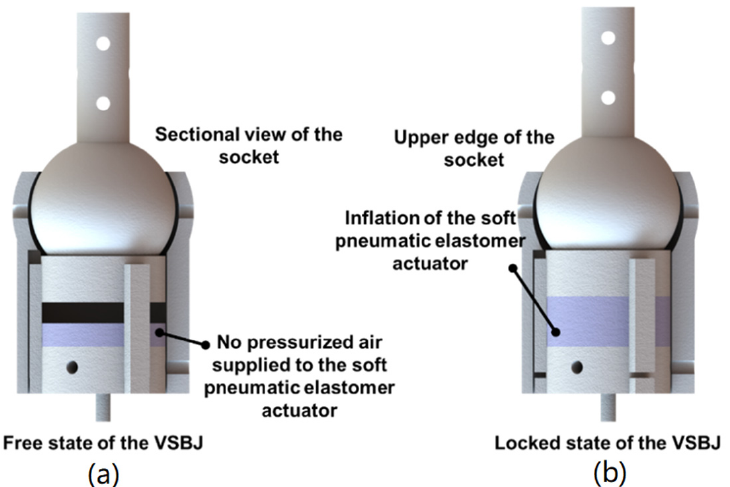
Figure 3. Schematic illustration of the working principle of the VSBJ: ( a ) The free state of the VSBJ; ( b ) the locked state of the VSBJ.